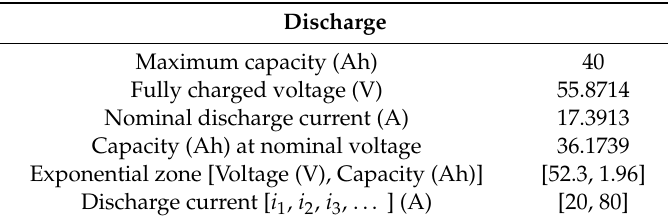
Table 4. Battery discharge parameters.